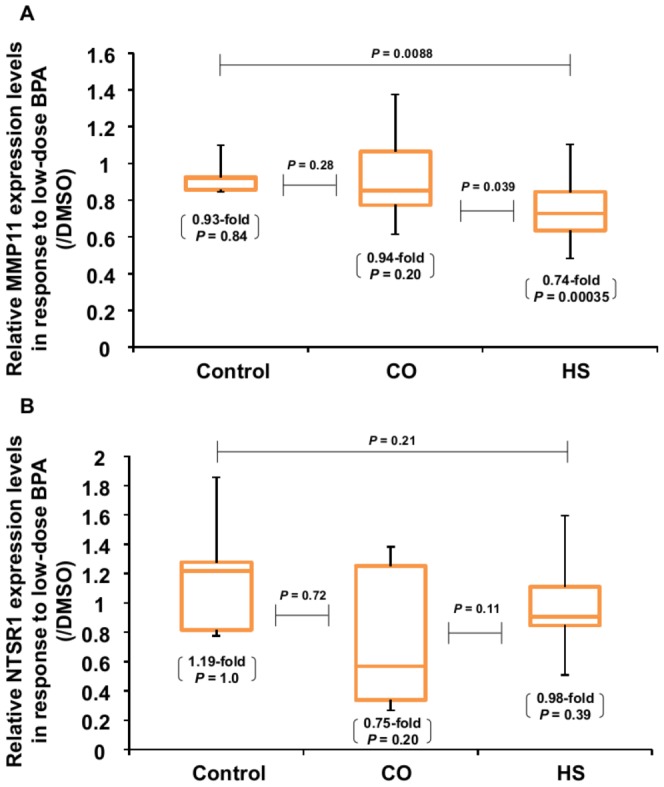
Difference in the genetic response to low-dose BPA in hFFCs derived from control children and child HS and CO patients.Cells were treated with 10 nM BPA for 24 h, and then the expression of MMP11 (A) and NTSR1 (B) was measured by TaqMan® real-time PCR. Significance was evaluated by the Mann-Whitney U test or Wilcoxon test. The bottom numbers indicate the fold changes and P value induced by BPA compared with DMSO control.